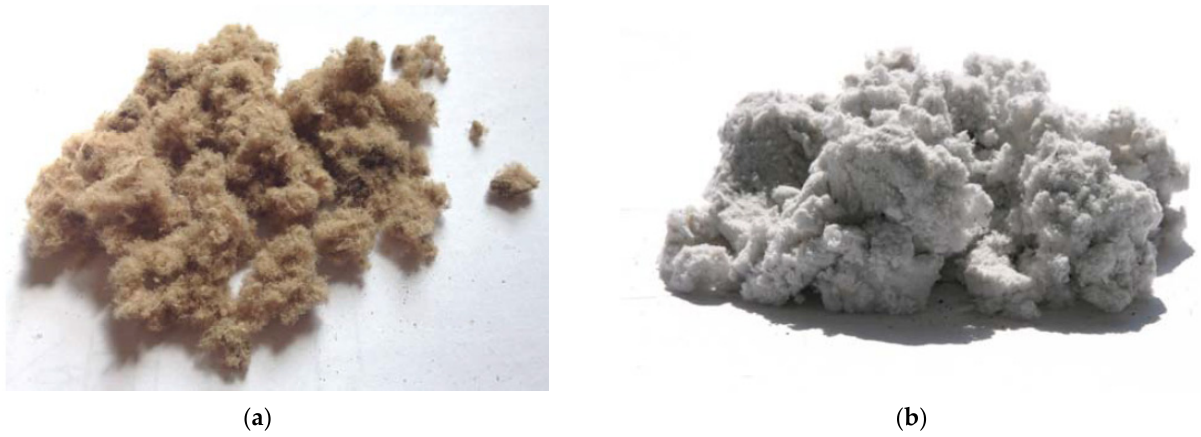
Figure 1. Appearance of finely divided technogenic fibrous materials obtained from: ( a ) corrugated cardboard, ( b ) coated writing paper.